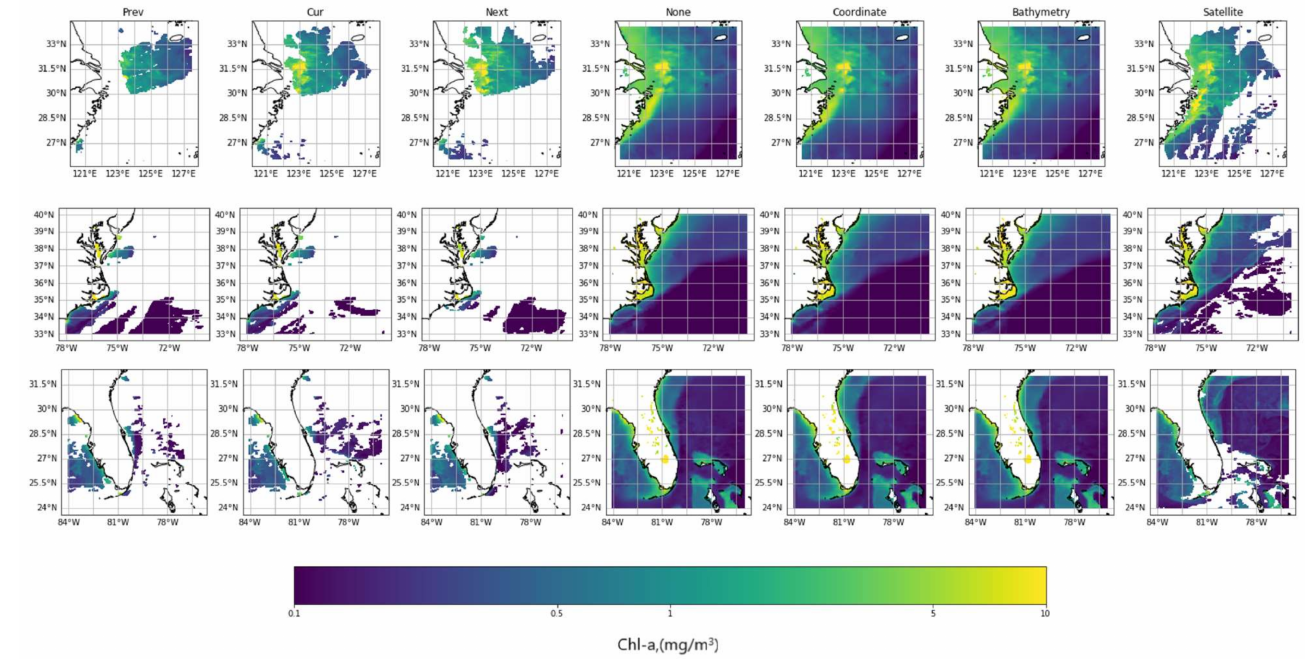
Figure 9. The reconstruction result of each model on specific days for training areas. The first three columns labeled “Prev”, “Cur” and “Next” denote masked Chl-a input of the previous day, the current day, and the next day. The three columns after Chl-a inputs are the reconstruction results of three models with different input schemes. The last column is the full satellite observation of the current day.